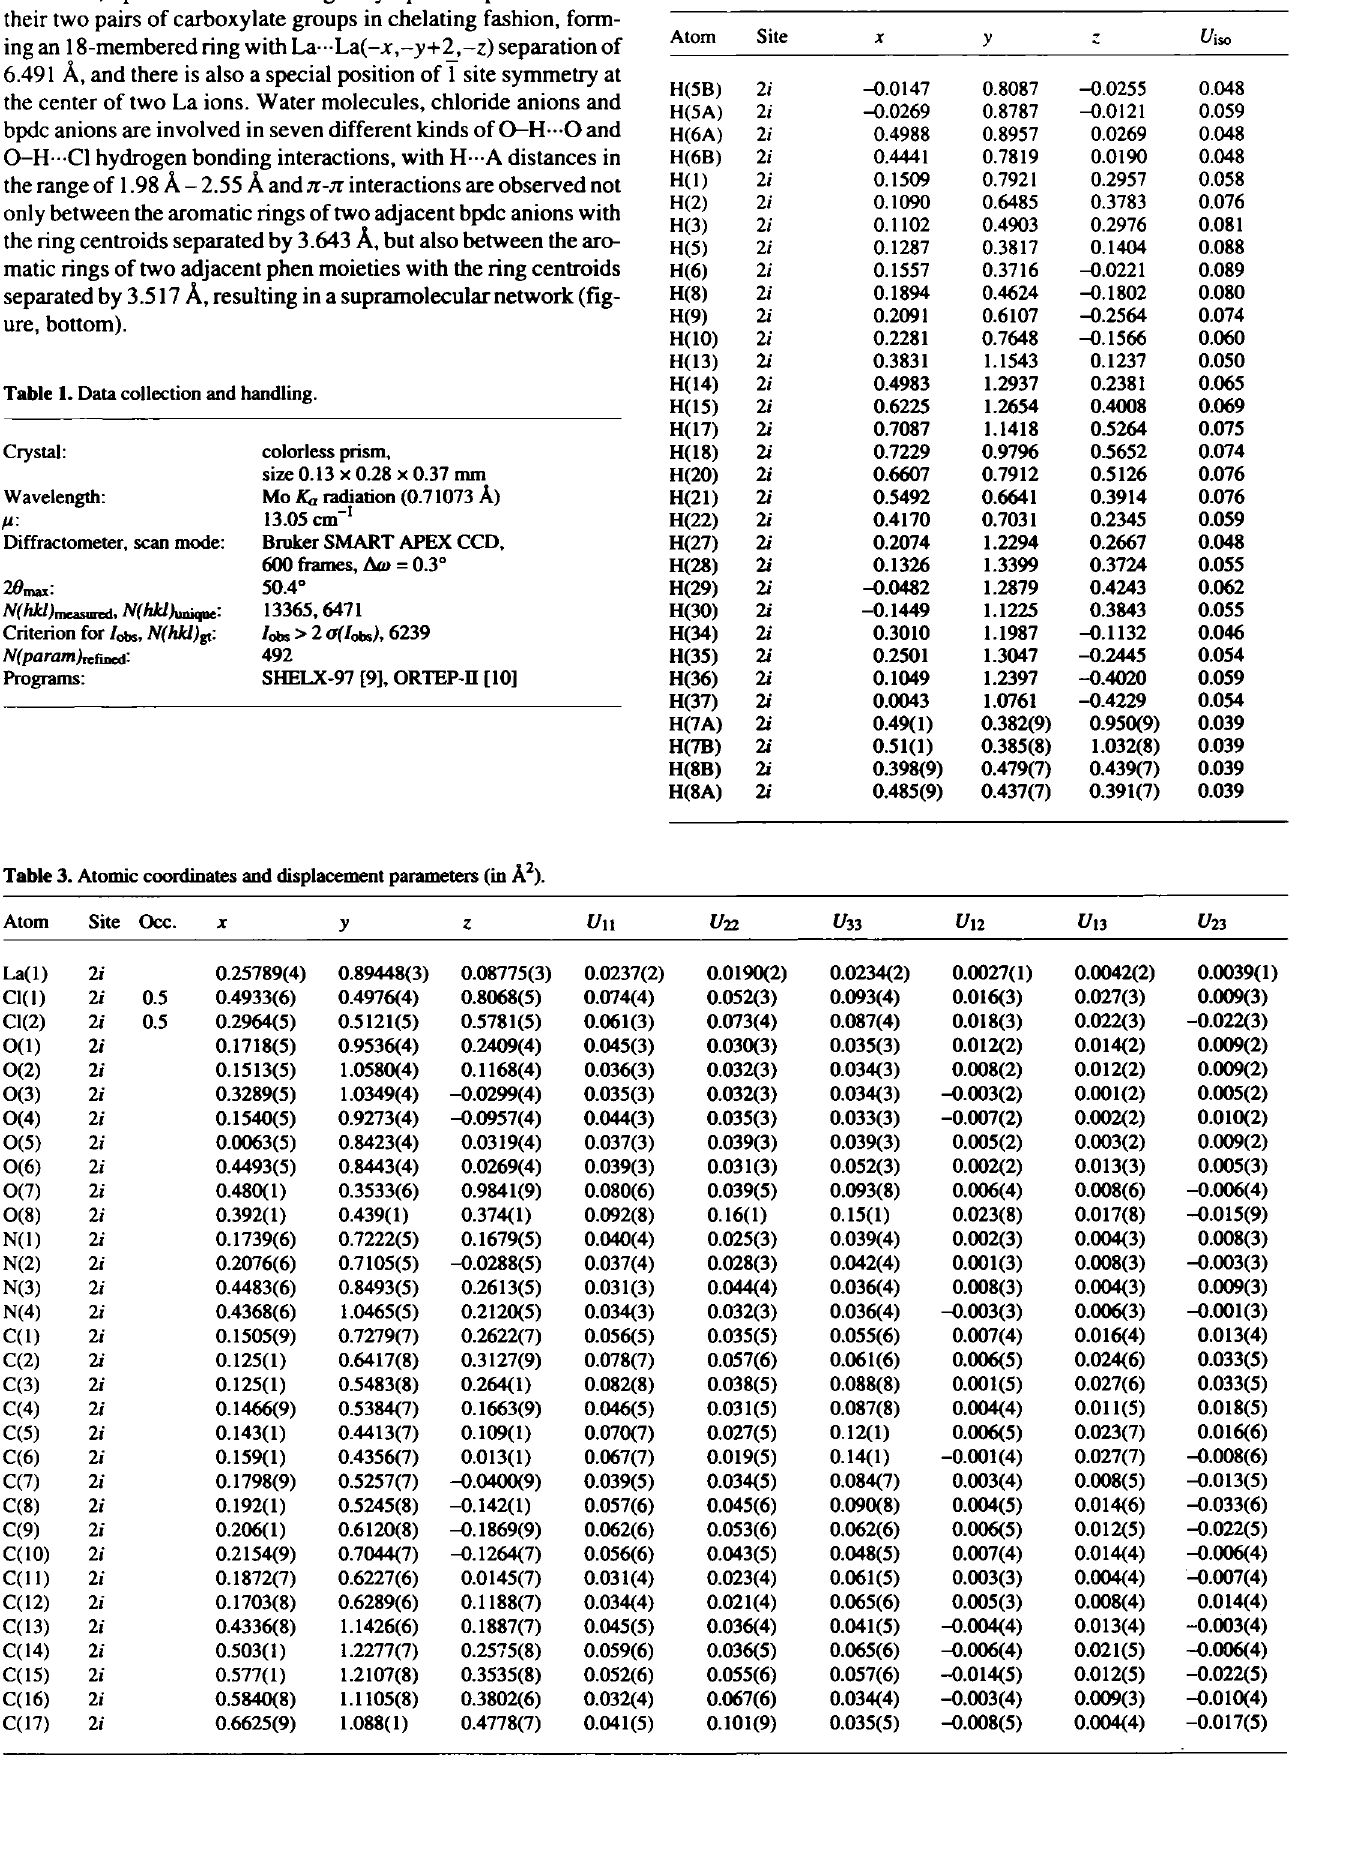
Table 2. Atomic coordinates and displacement parameters (in À 2 ).